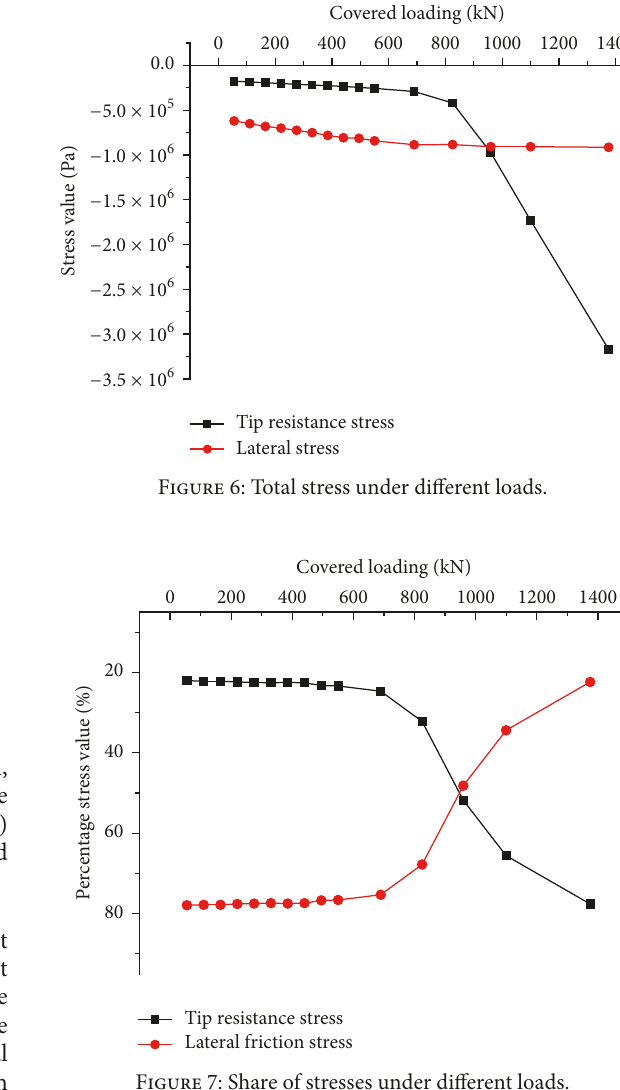
Figure 7: Share of stresses under different